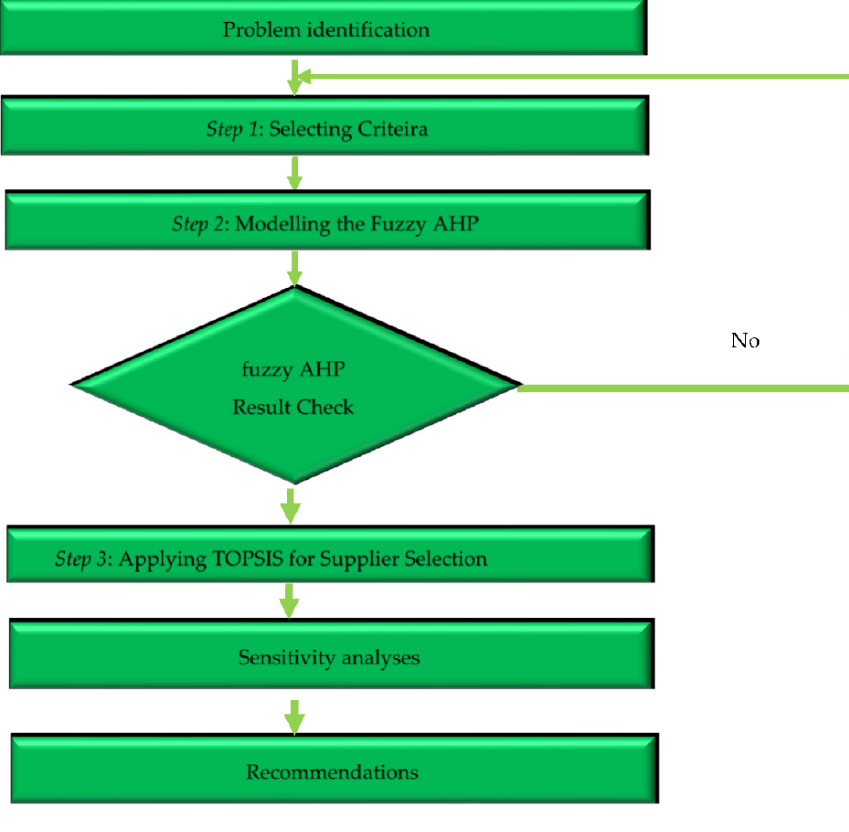
Figure 3. Research graph.